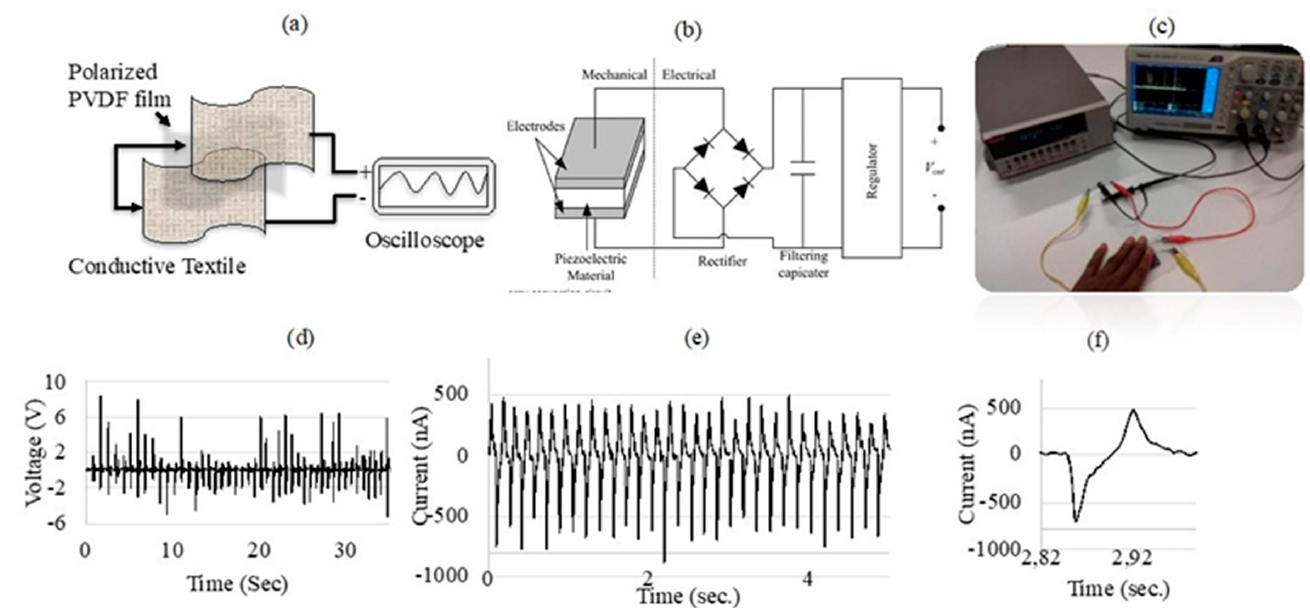
Figure 3. Oscilloscopic analysis of the PSTS ( a ); the entire circuit diagram ( b ); the experimental setup by hand pressing ( c ); the output voltage response ( d ); the short-circuit current ( e , f ) of the enlarged view of a complete single peak in the current signal.